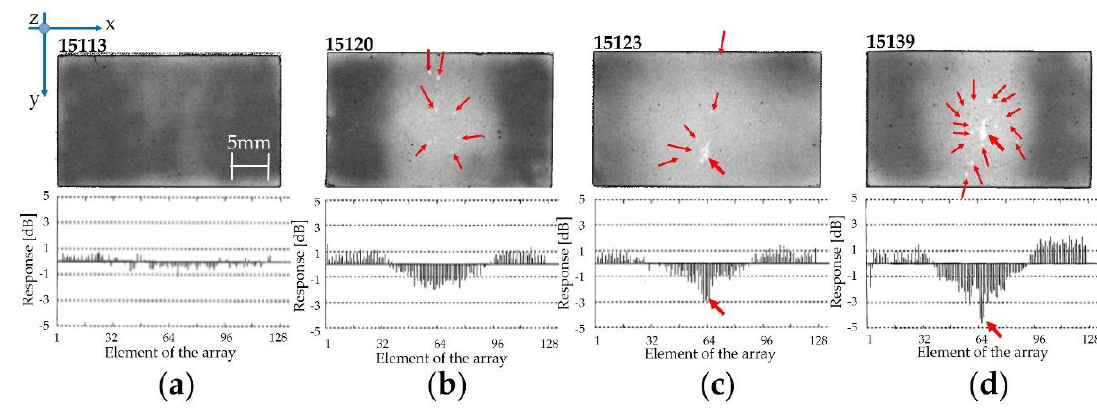
Figure 13. C-scans for adhesive 1 and the corresponding pulse-echo test diagrams: ( a ) sample 15,113 (lot #1); ( b ) sample 15,120 (lot #2); ( c ) sample 15,123 (lot #2); ( d ) sample 15,139 (lot #4).